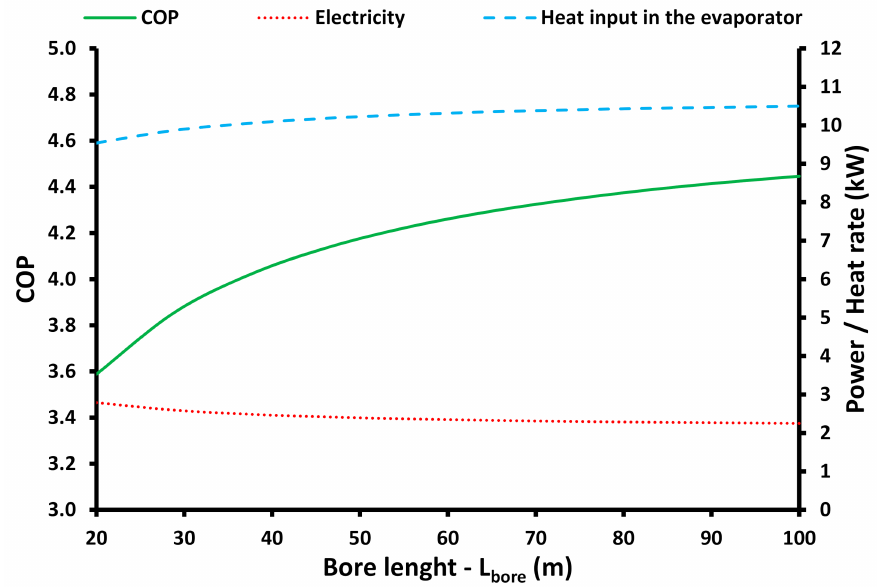
Figure 22. The impact of the borehole length on the COP, electricity consumption and heat input in the evaporator.